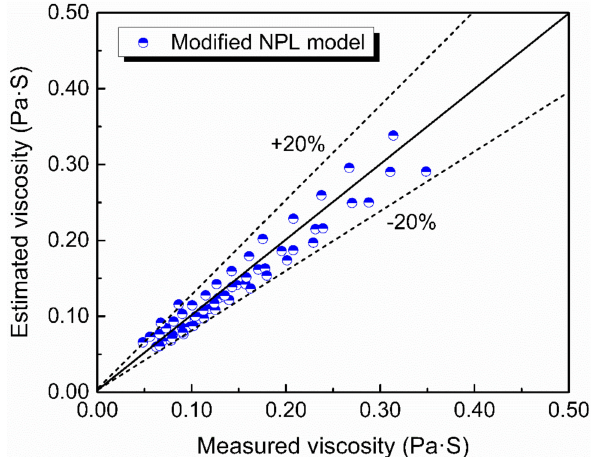
Figure 12. The estimated viscosity against the measured viscosity using modified NPL model.